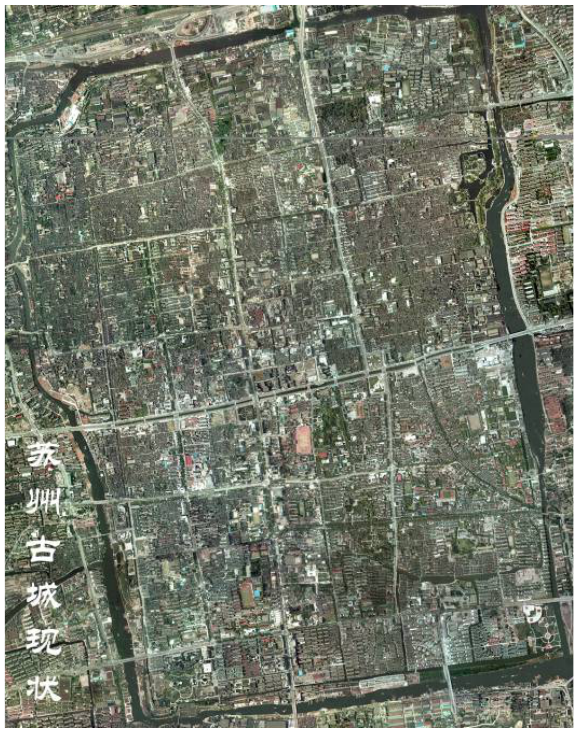
Figure 1. An aerial photograph of Suzhou in 2004 Data source: Chinese Urban Planning and Research